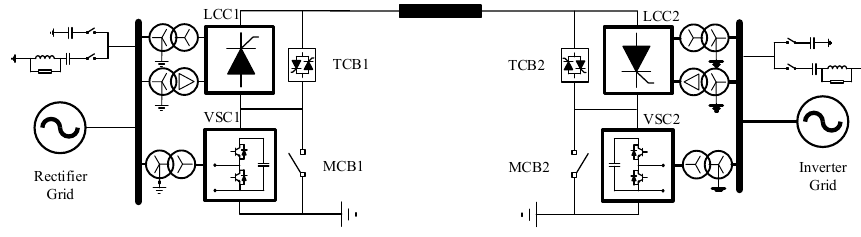
Figure 1. LCC-VSC serial hybrid HVdc structure.